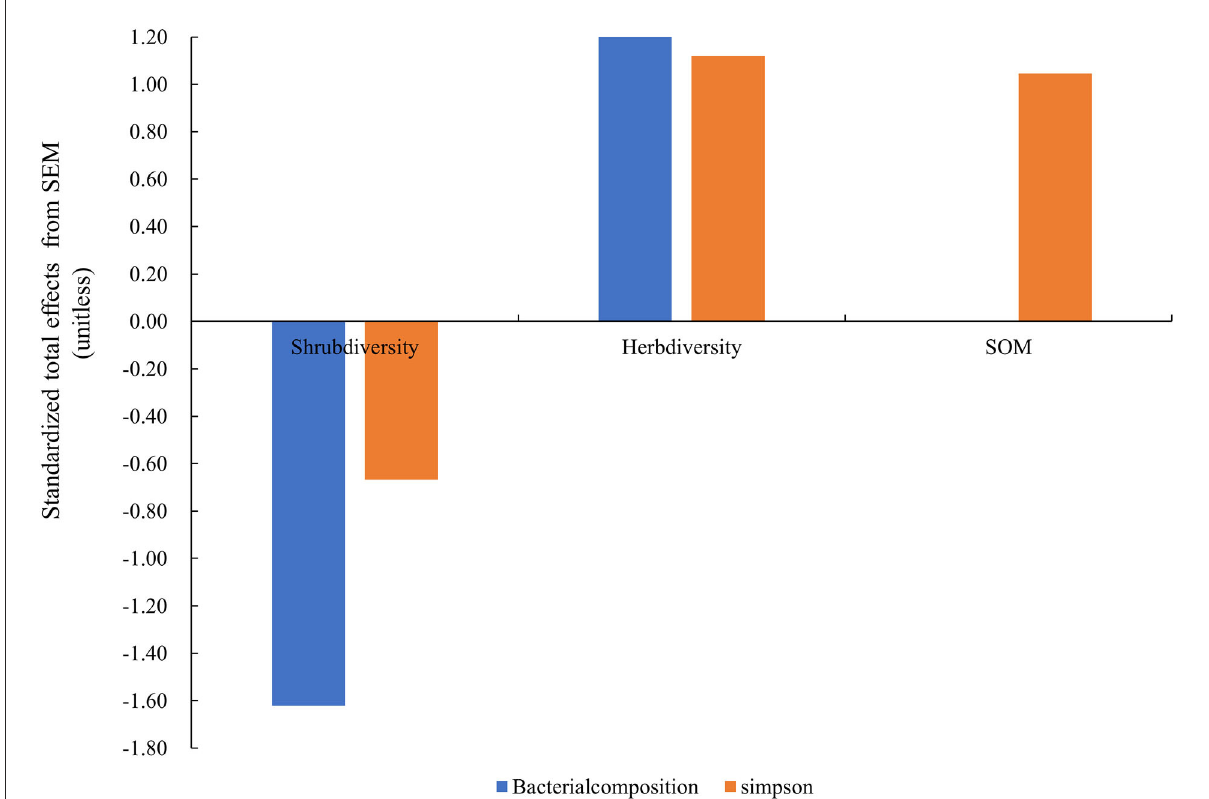
FIGURE8 Standardized total effects (direct plus indirect effects) derived from the structural equation modeling. Herb diversity: four plant diversity indices of the herb layer; SOM: soil organic matter; shrub diversity: four plant diversity indices of the shrub layer; bacterial composition: the sequencing data for bacteria at the phyla level; Simpson: Simpson index of bacteria community.